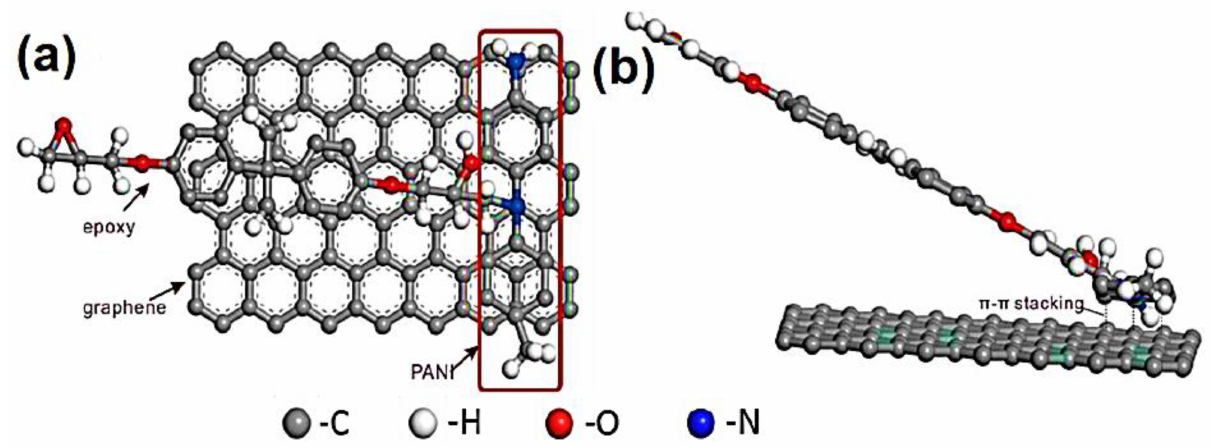
Figure 5. Schematic of proposed interfacial bonding mechanism ( a ) vertical view and ( b ) front view. Reprinted with permission from Ref. [77]. 2018,